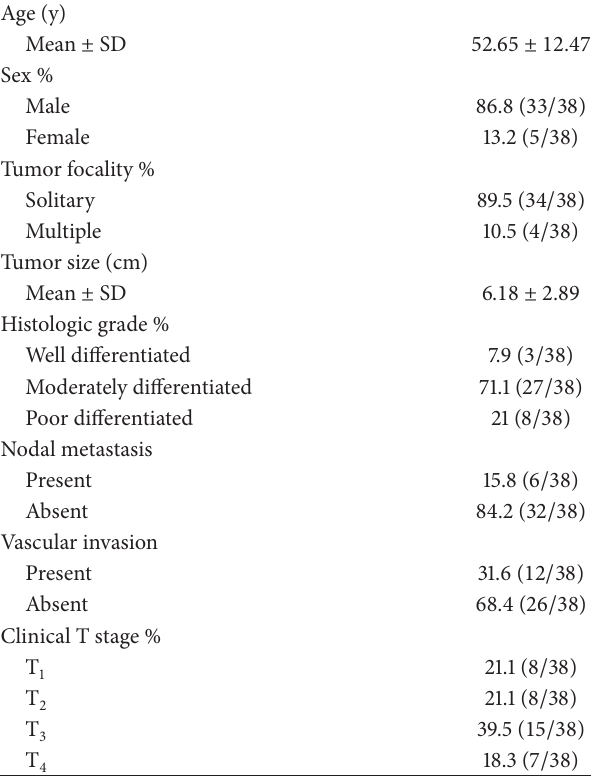
Table 1: Clinicopathologic characteristics of HCC